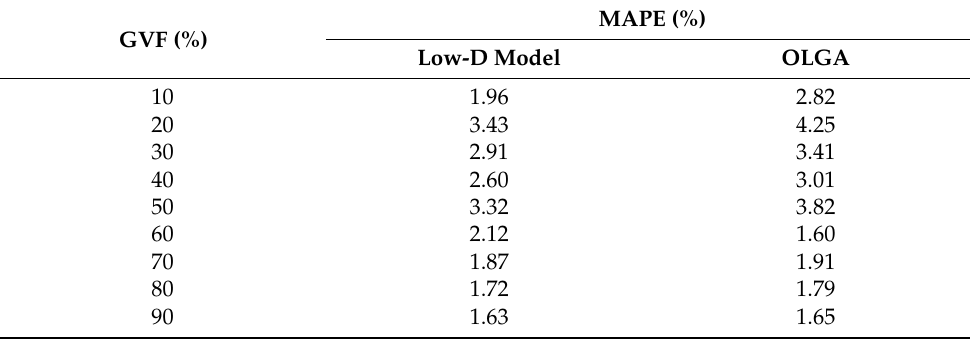
Table 4. Low-D model and OLGA MAPE